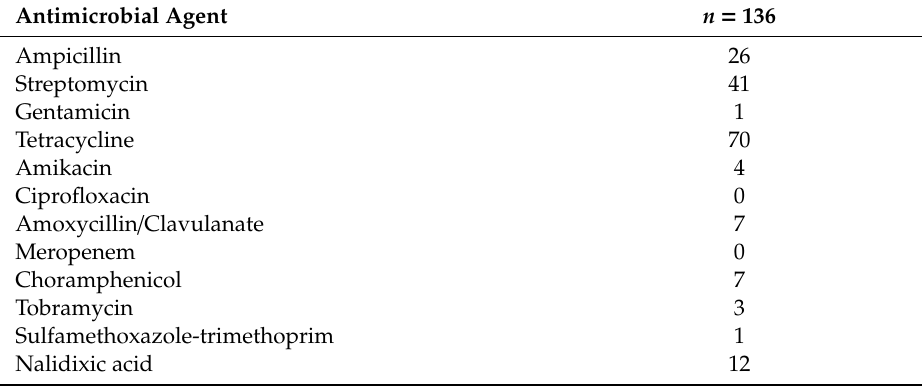
Table2. Percentageof E.coli